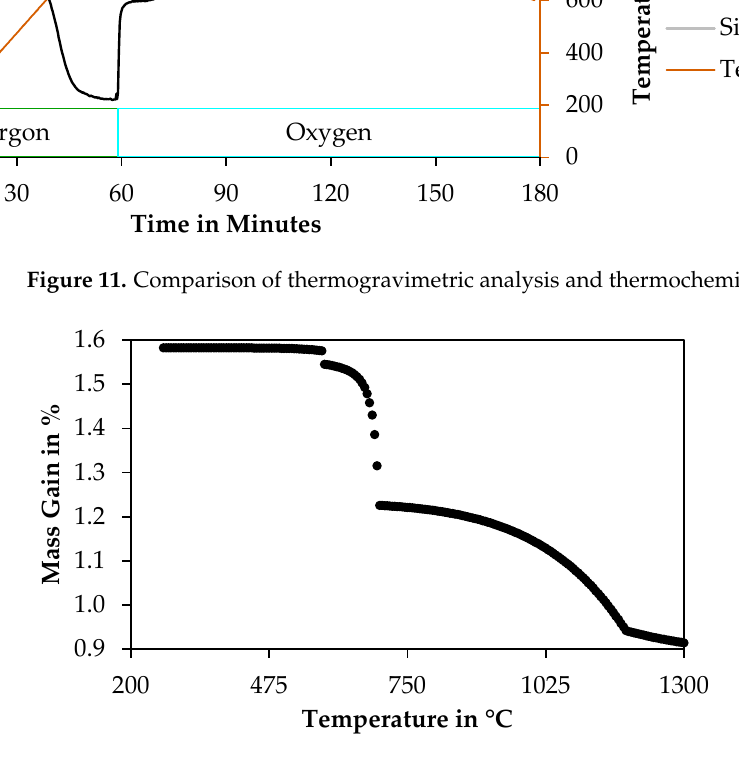
Figure 12. Mass gain in dependence of temperature according to thermochemical simulation.